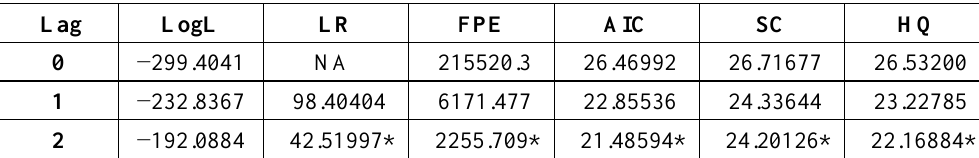
Table 3. VAR Lag Order Selection Criterion